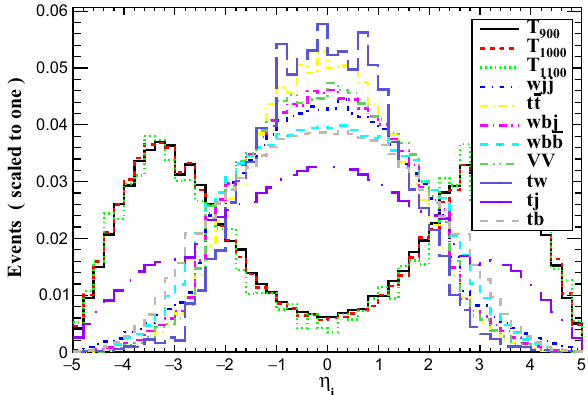
Fig. 5 Normalized distribution of the rapidity of the forward jet for the signals and backgrounds